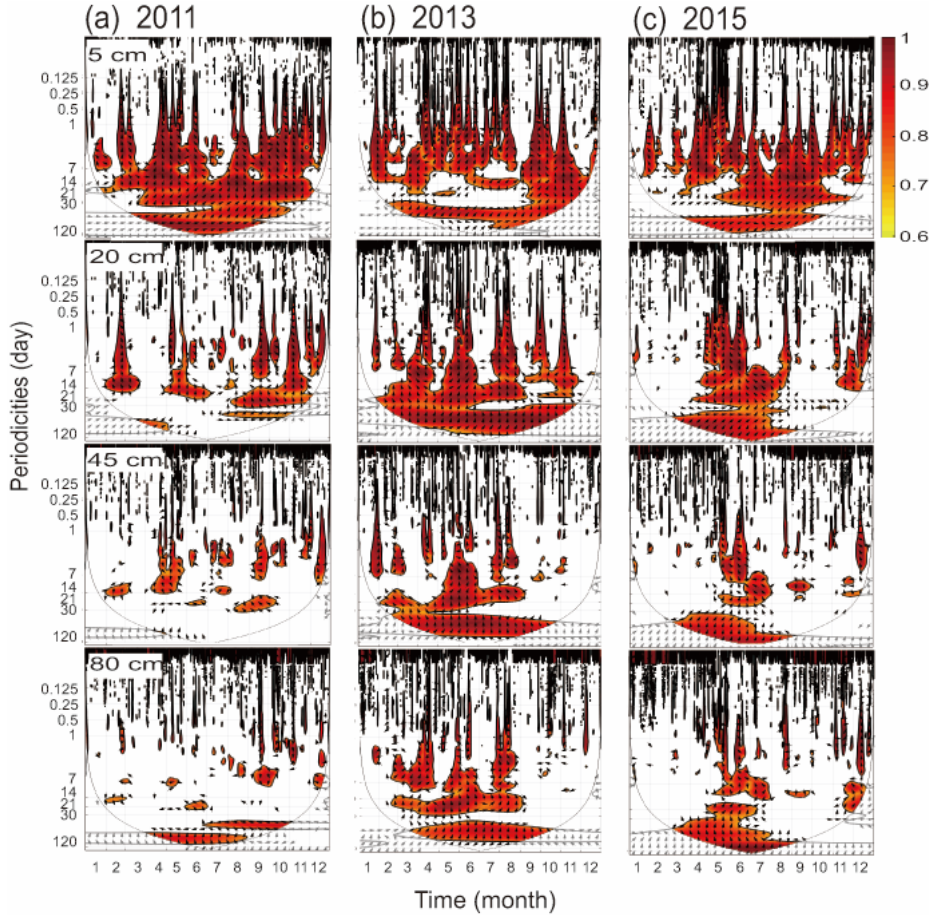
Figure 4. Same as Figure 3, but for woodland.